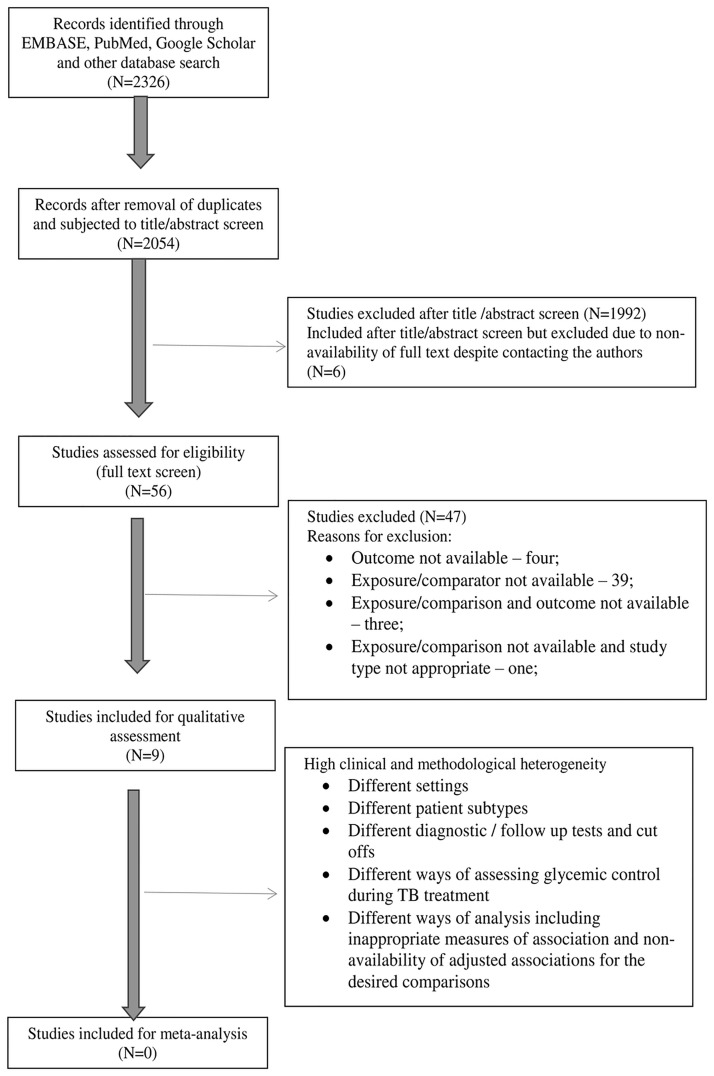
PRISMA flow diagram through different phases of the systematic review [39].